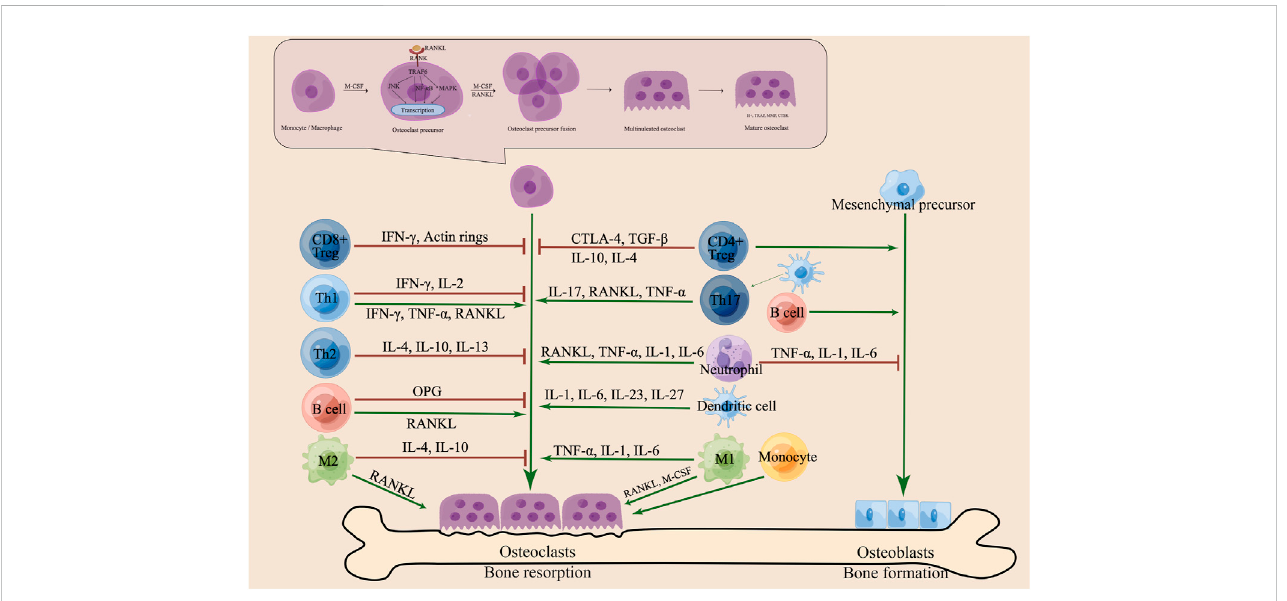
FIGURE 1 Schematic diagram of the interaction between immune cells and osteoclasts (OCs). Various immune cells and secreted cytokines act on OCs and osteoblasts (OBs) to maintain bone homeostasis on the bone surface. Th-cell subsets (Th1, Th2, Th17, Treg) play an important role in modulating the differentiation and maturation of OCs. Th1 cells secrete IFN- γ , IL-2, TNF- α and RANKL and Th2 cells secrete IL-4, IL-10, and IL-13 to regulate osteoclastogenesis. Th17 cells secrete IL-17, RANKL and TNF- α to enhance OC differentiation and bone resorption. CD4 + Tregs promote the bone formation and secrete CTLA-4, TGF- β , IL-10 and IL-4 to promote apoptosis and inhibit bone resorption. CD8 + Tregs secrete IFN- γ to inhibit the formation of the actin ring and OC activity. However, B cells secrete OPG and RANKL to regulate bone health. The two subtypes (M1 and M2) of macrophages (M φ s) differentiateinto OCandsecretecytokinesto regulateosteoclastogenesis.Monocytes (Mo),dendritic cells(DC)and neutrophils andcytokines areassociated with OC formation and function. Pre-OCs are derived from monocytes/macrophages and differentiate into mature OCs under stimulation with M-CSF and RANKL. RANKL induces the receptor RANK on the OC surface, which recruits TRAF6 to activate downstream pathways and transcription factors. OC precursors fuse into multinucleated cells and then secrete H+, TRAP, MMP, and CTSK to absorb bone on the bone surface. Pre-OBs are derived from mesenchymal precursors and differentiate into mature OBs, which support bone formation on the bone